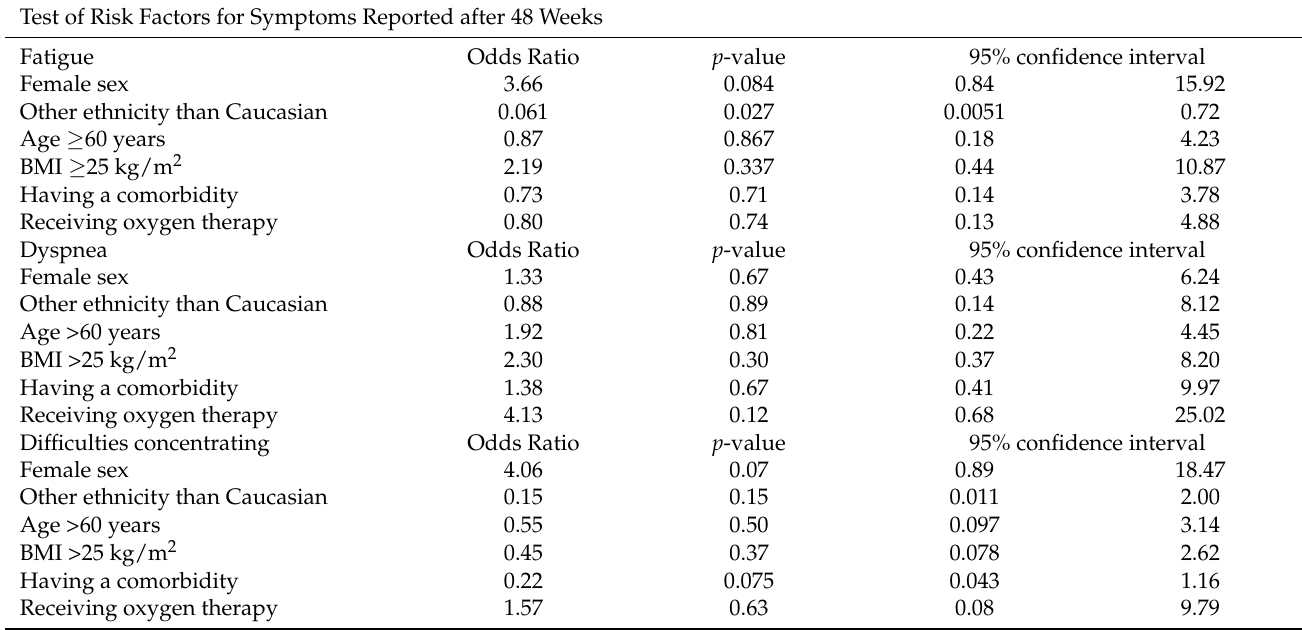
Table A3. Tests of risk factors for the most common reported symptoms after 48